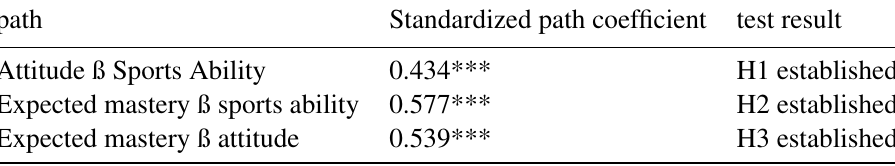
Table 7 Estimation results of the structural equation